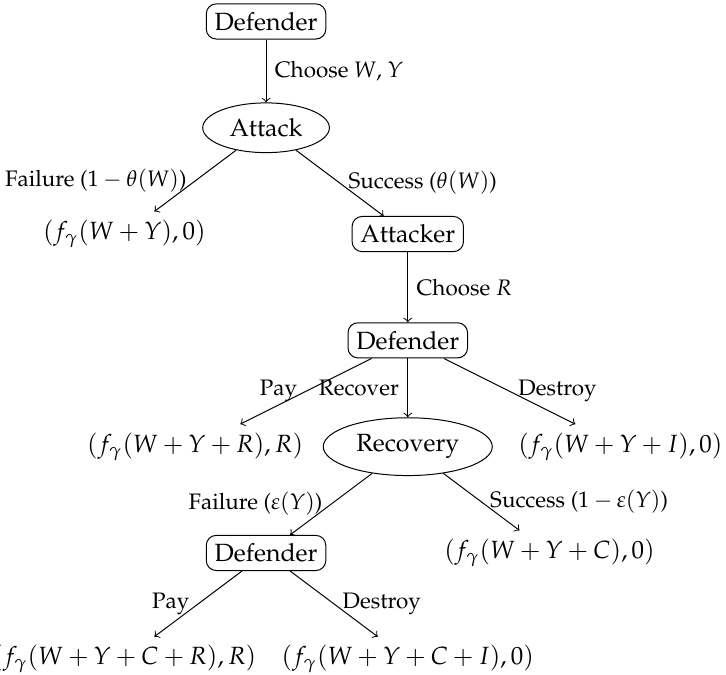
Figure 1. The Attacker-Defender (A-D) game tree, with corresponding utilities ( U d , U a ) under each possible game outcome. Rounded corners indicate the player whose turn it is to move; ovals indicate stochastic events (with probabilities written next to each outcome). The argument in f γ () is the defender’s total cost, whose expression changes depending on the different realizations of the